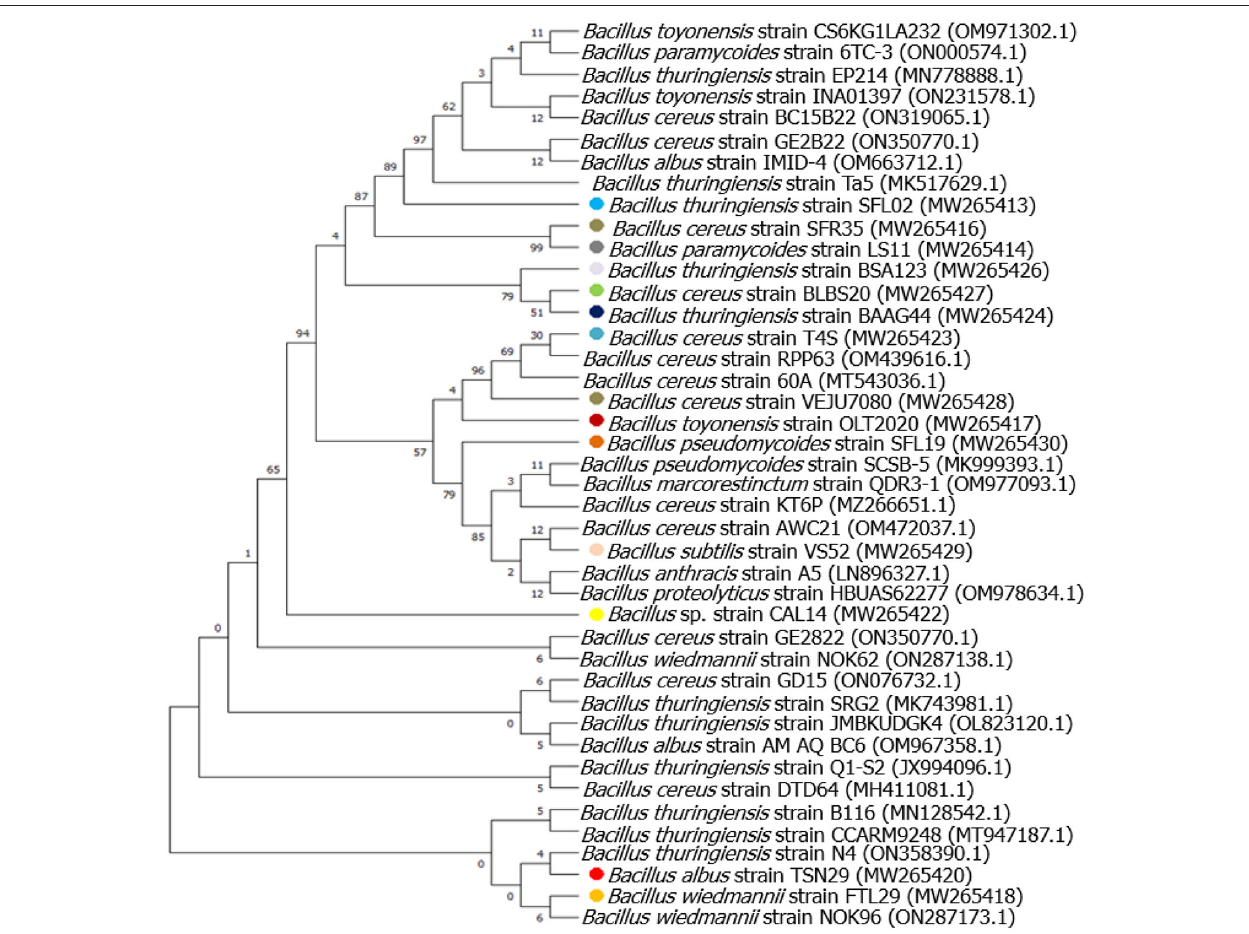
FIGURE 2 | Evolutionary relationships of taxa tree based on partial 16S rRNA sequences using maximum likelihood-based on the Tamura-Nei model showing relationships between the endophytic Bacillus species and its closely related strains from NCBI